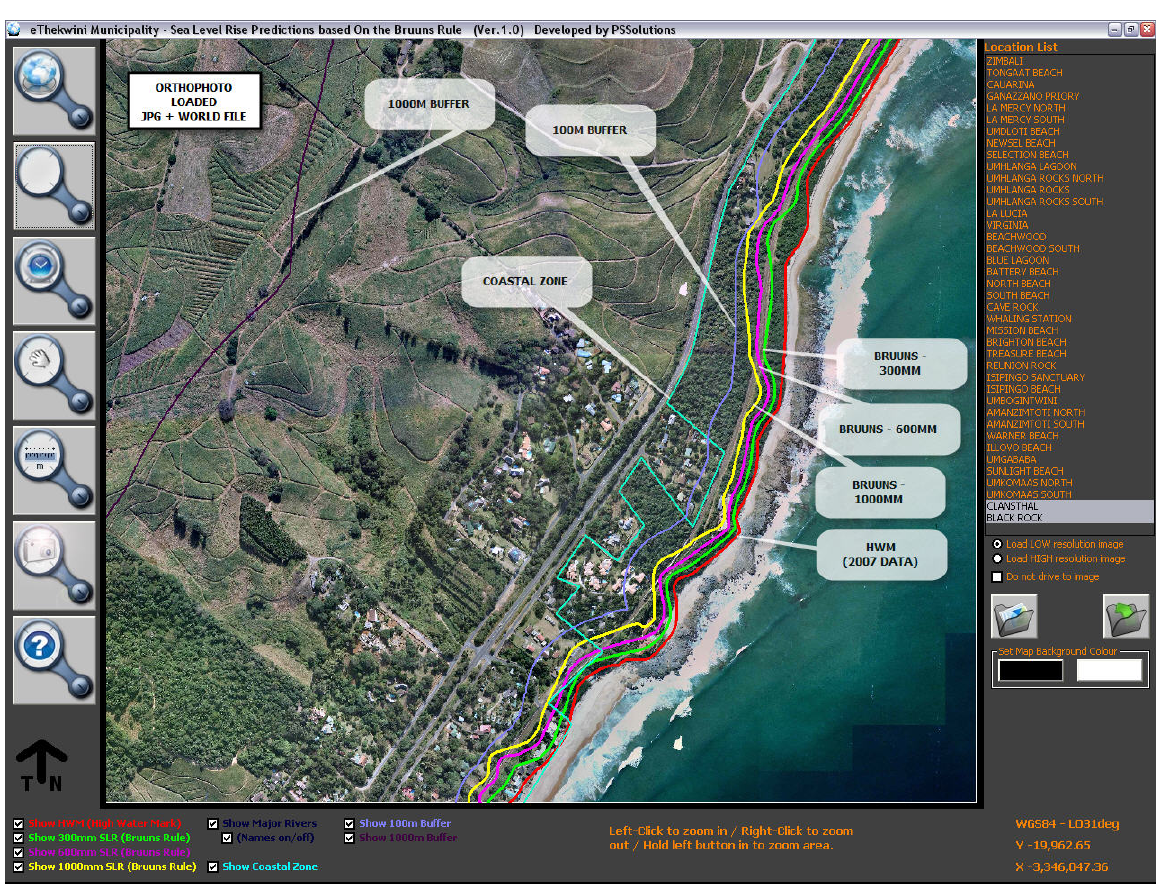
Figure 5. Screen view of the standalone SLR viewer [48].